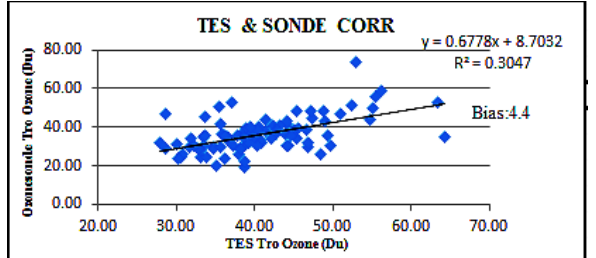
In this comparison, the correlation coefficient R= 0.548 and the mean variance of tropospheric ozone OMI value obtained by Ozonesonde is 9.02 Dobson. Then the tropospheric ozone amount of TES instrument was obtained also according to the above methods described that the results of validation of these values with Ozonesonde is shown in Figure 7. The results shown in Figures 6 and 7 show the correlation is almost identical to each of the satellite data with data Ozonesonde with this difference that mean variance of tropospheric ozone of TES with Ozonesonde is 4.4 Dobson; approximately half the difference of OMI with Ozonesonde. The next step is to increase the vertical resolution of satellites values of the average of the data and then again compare them with Ozonesonde.